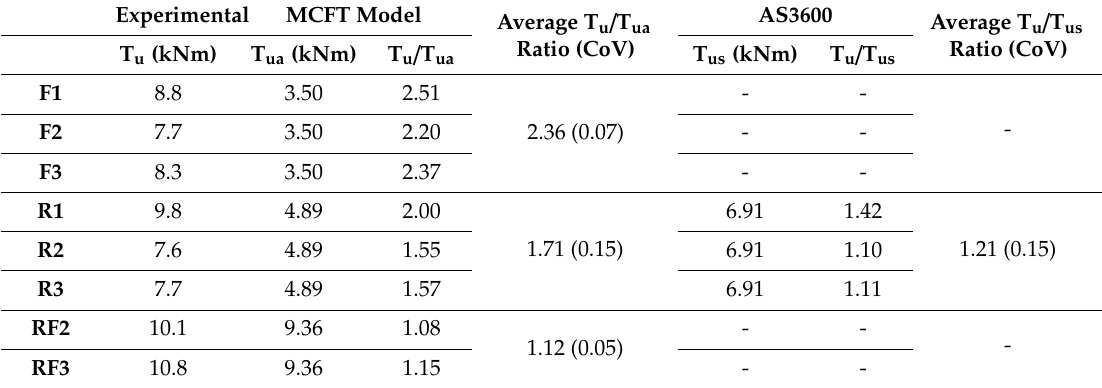
Table 8. Torsional strength comparison of experimental results to MCFT and AS3600 analytical results. Brackets indicate the coe ffi cient of variance (CoV) of the average ratio of experimental torque to